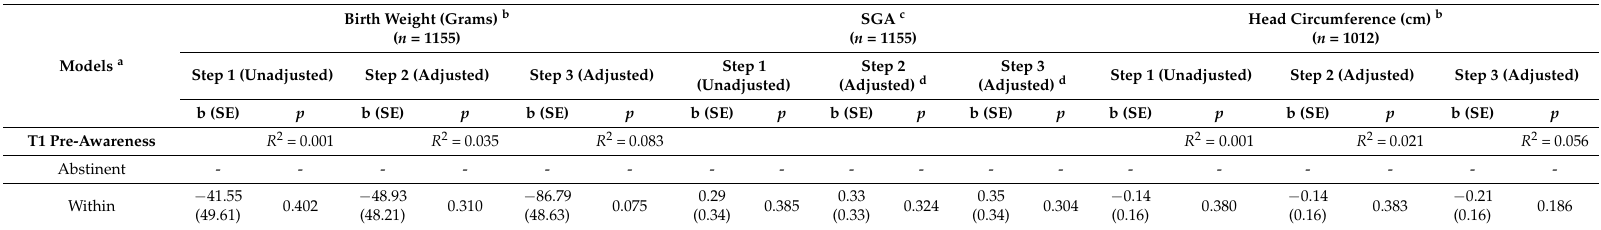
Table 4. Guideline adherence as a predictor of birth outcomes ( n =